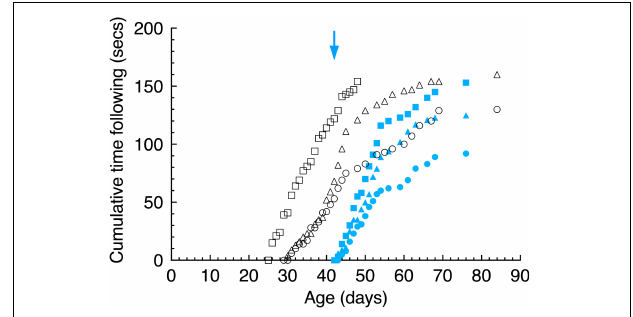
FIGURE 9 | Cumulative gaze following behavior of a moving laser spot in daily 15 s episodes as a function of age. Data are displayed for 3 light-exposed (open black symbols: C117 triangles, C118 circles, C119 squares) and 3 dark-reared kittens (blue filled symbols: C114 triangles, C115 circles, C116 squares). The blue arrow indicates the age of the dark-reared kittens when they were first introduced to light (at P42 days). The blue arrows indicate the age of the dark-reared kittens when they were first exposed to